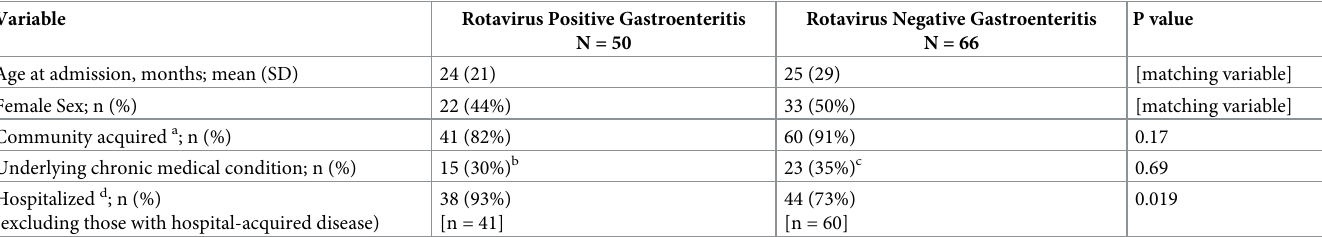
Rotavirus Negative Gastroenteritis P N = 50 N = 66